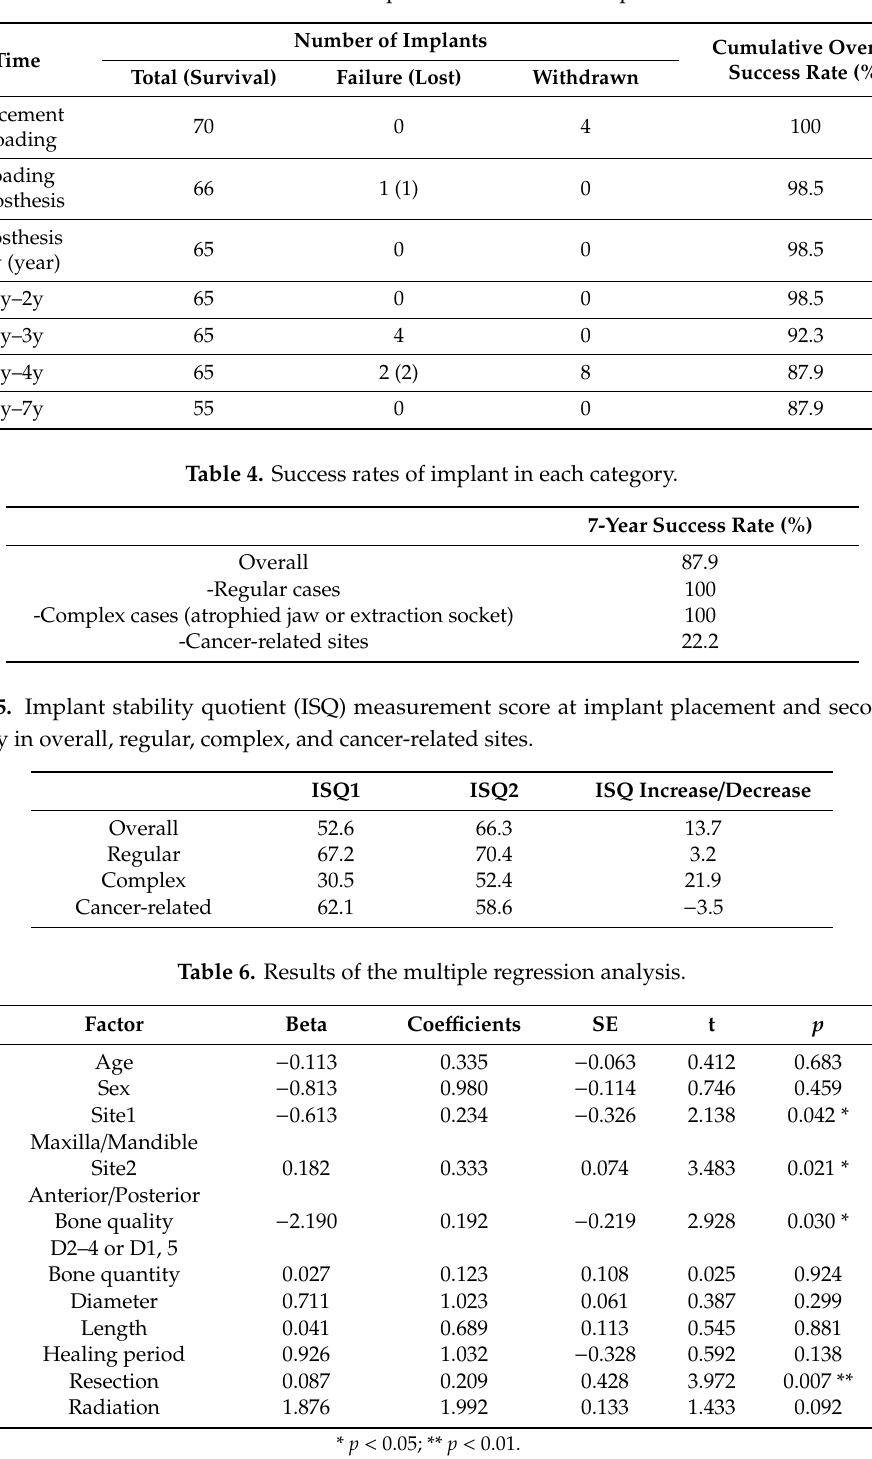
Table 3. Life table of photofunctionalized implants.